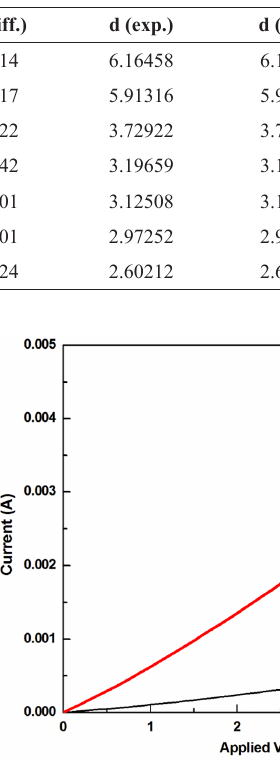
Figure 6. I-V curves of (a) pure PANI (b) PANI